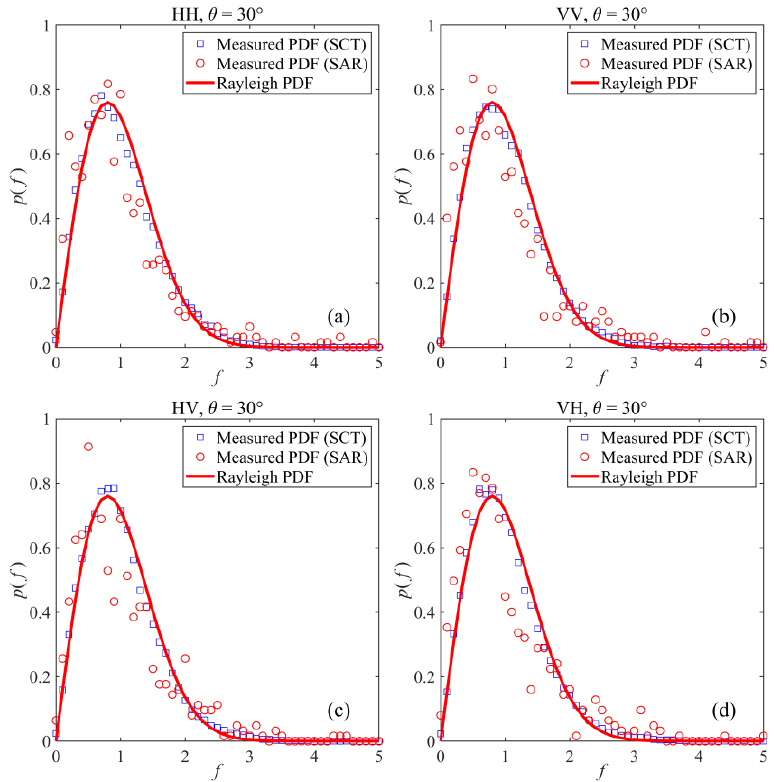
Figure 20. Comparison of amplitude statistics between scatterometric and SAR data (Resolut. = 0.07 m) at ( a ) HH, ( b ) VV, ( c ) HV, and ( d ) VH polarizations.